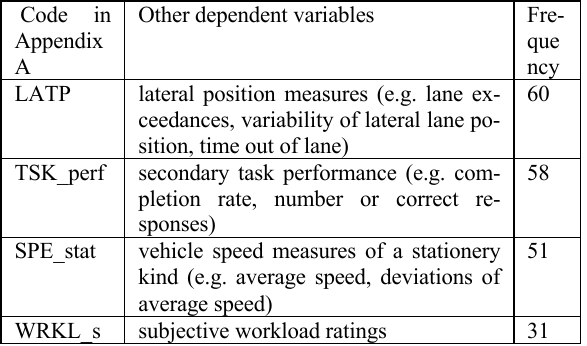
Table 6. Frequency of used other observed variables.